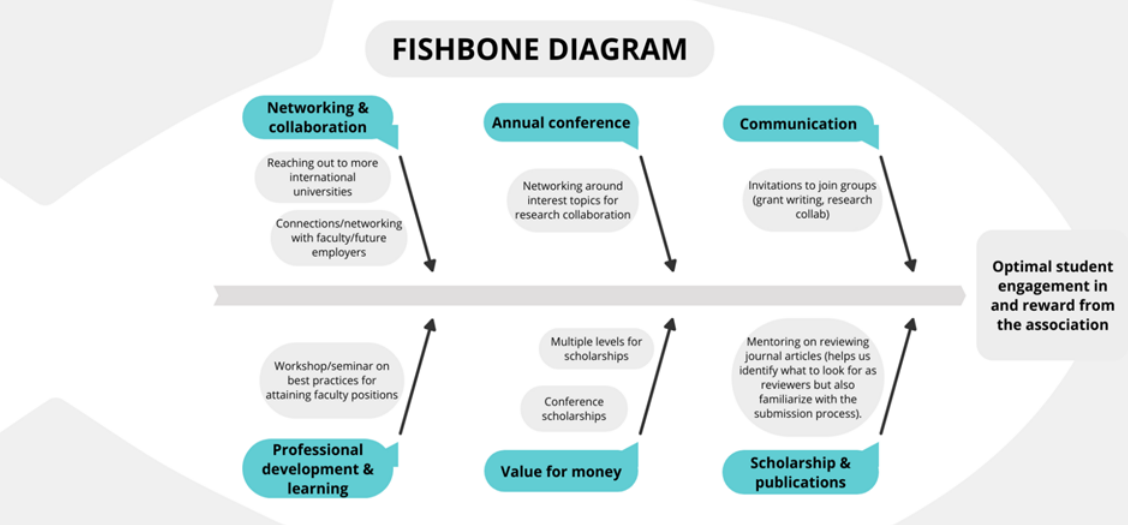
Fishbone Diagram with the Top Seven Areas to Optimize Association Engagement with